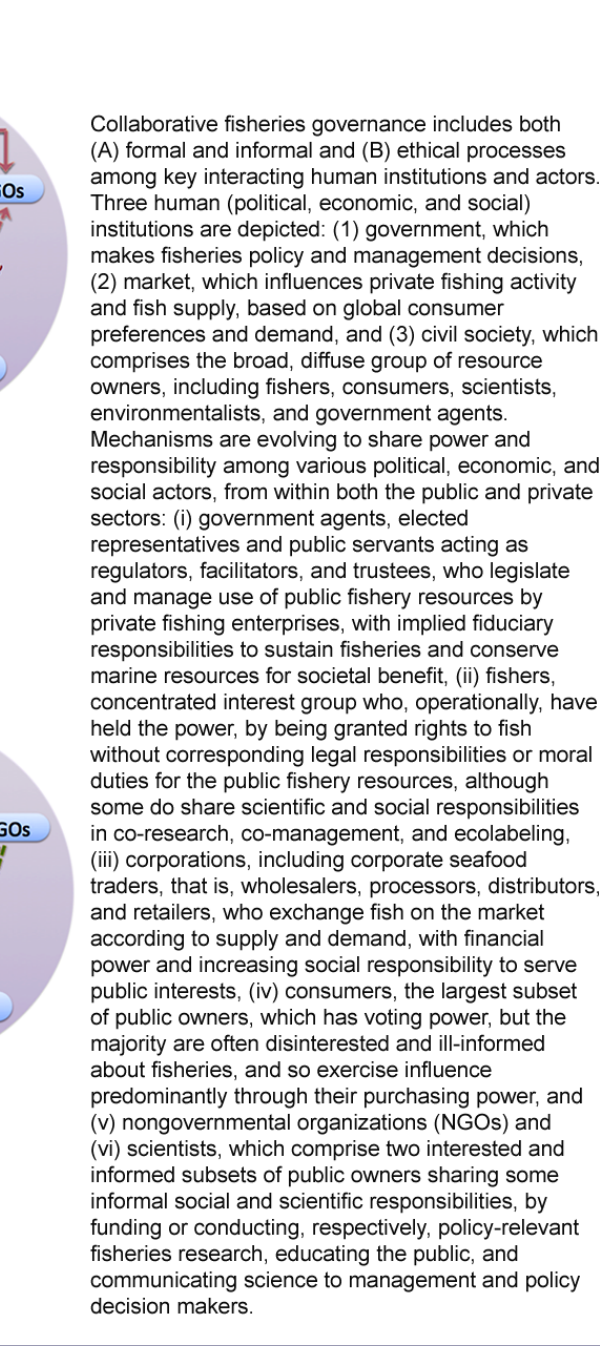
Fig. 3. Evolving a social contract for ethical